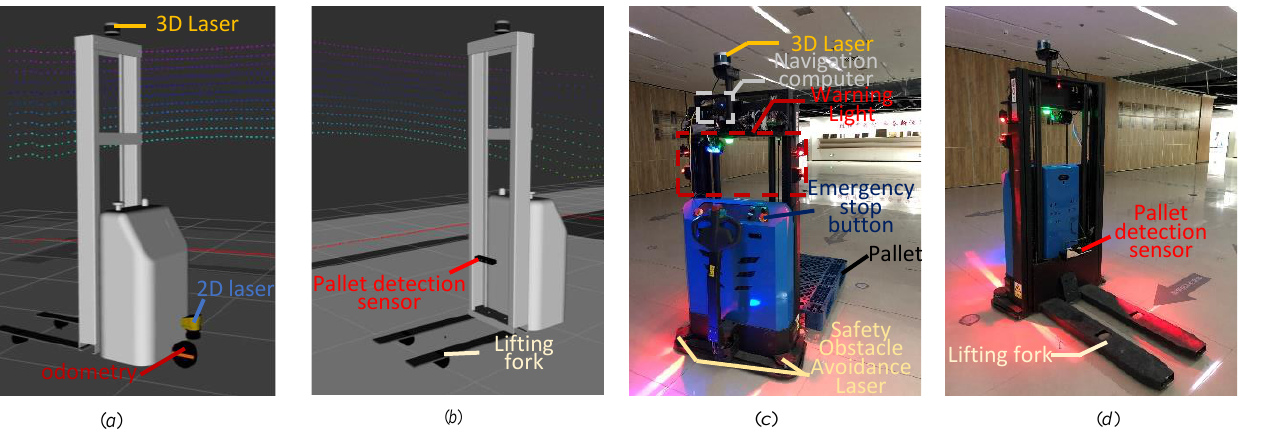
Figure 9. Experimental model. ( a ) Simulation forklift forward view. ( b ) Simulation forklift rear view. ( c ) Forklift forward view. ( d ) Forklift rear